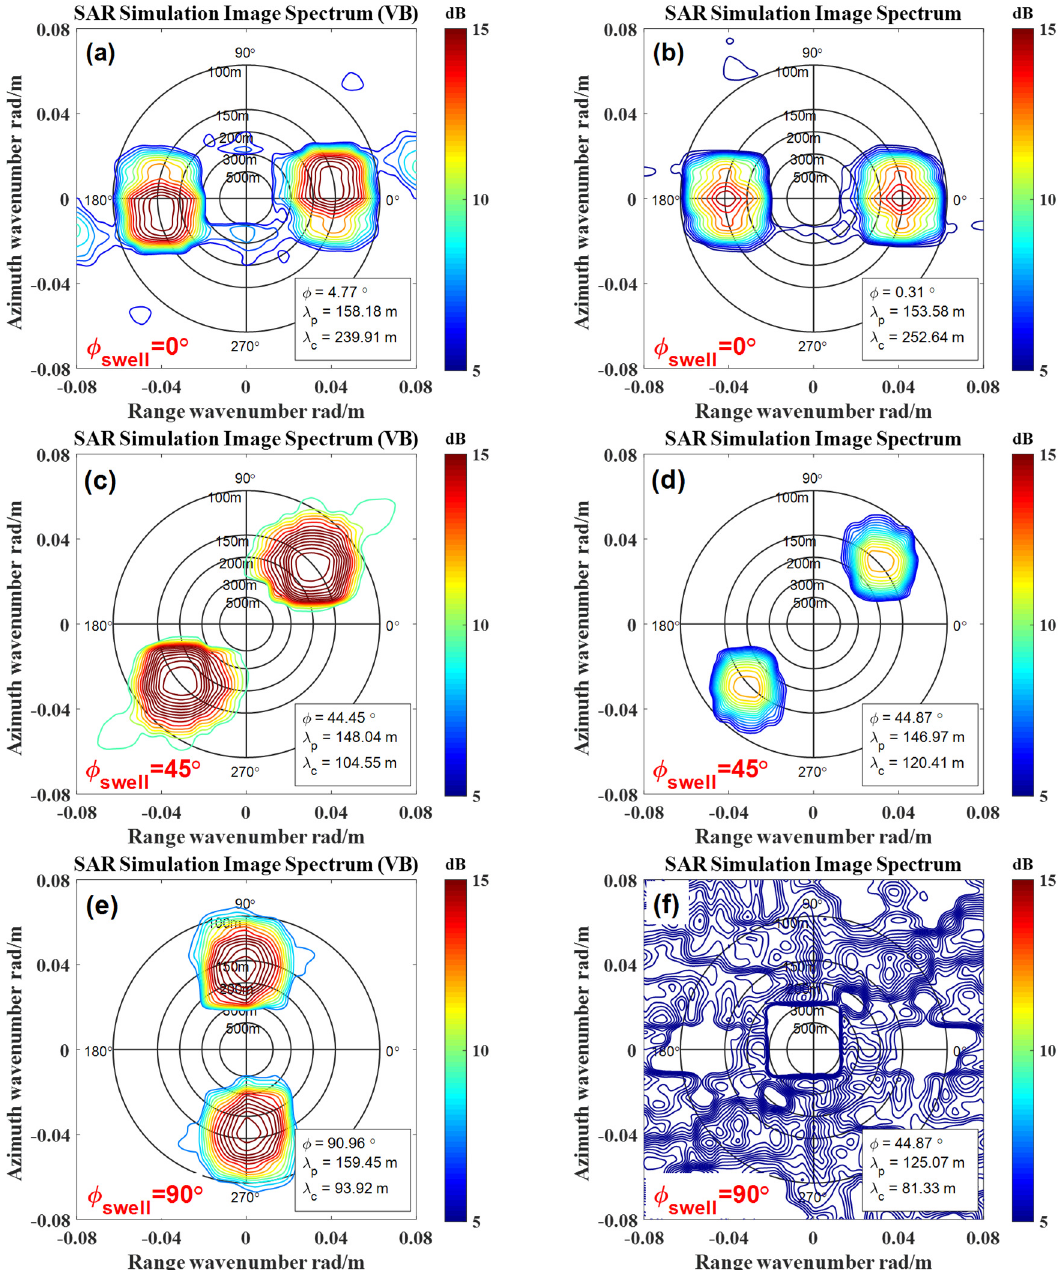
Figure 13. The SAR image spectra corresponding to the SAR images in the Figure 12.